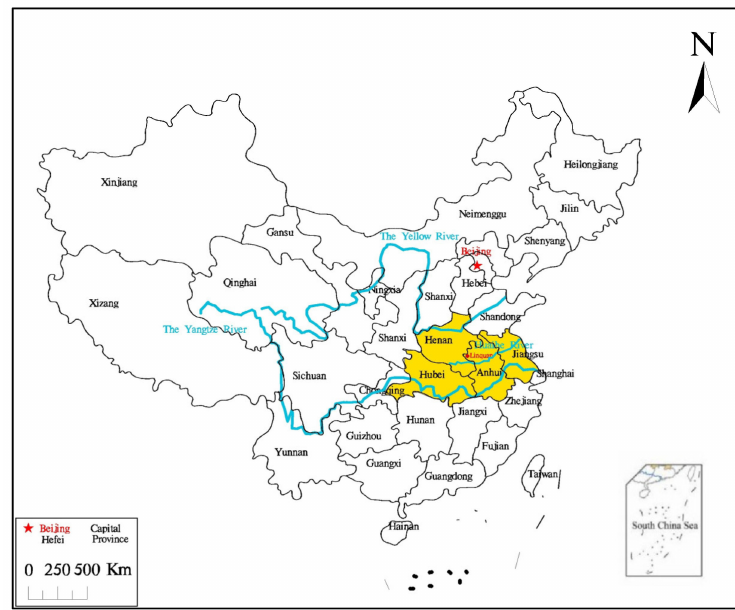
Figure 1. Location map showing the Huaihe River Basin.